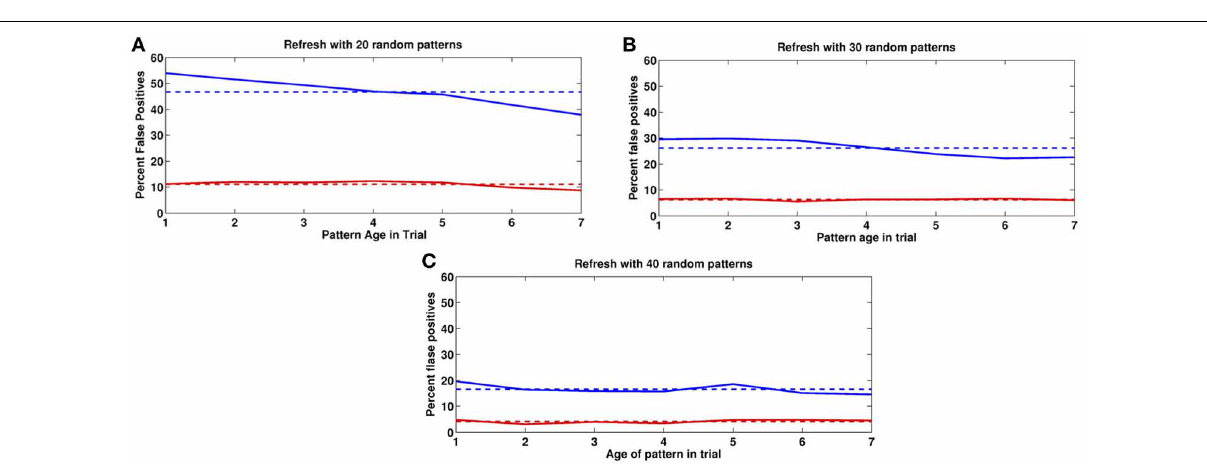
FIGURE 9 | False positives for novel images. False positive rates as a function of age in past trials. Blue: previous trial. Red: two trials back. Horizontal lines correspond to means. (A) 20, (B) 30, (C) 40 random image presentations in the Inter-trial